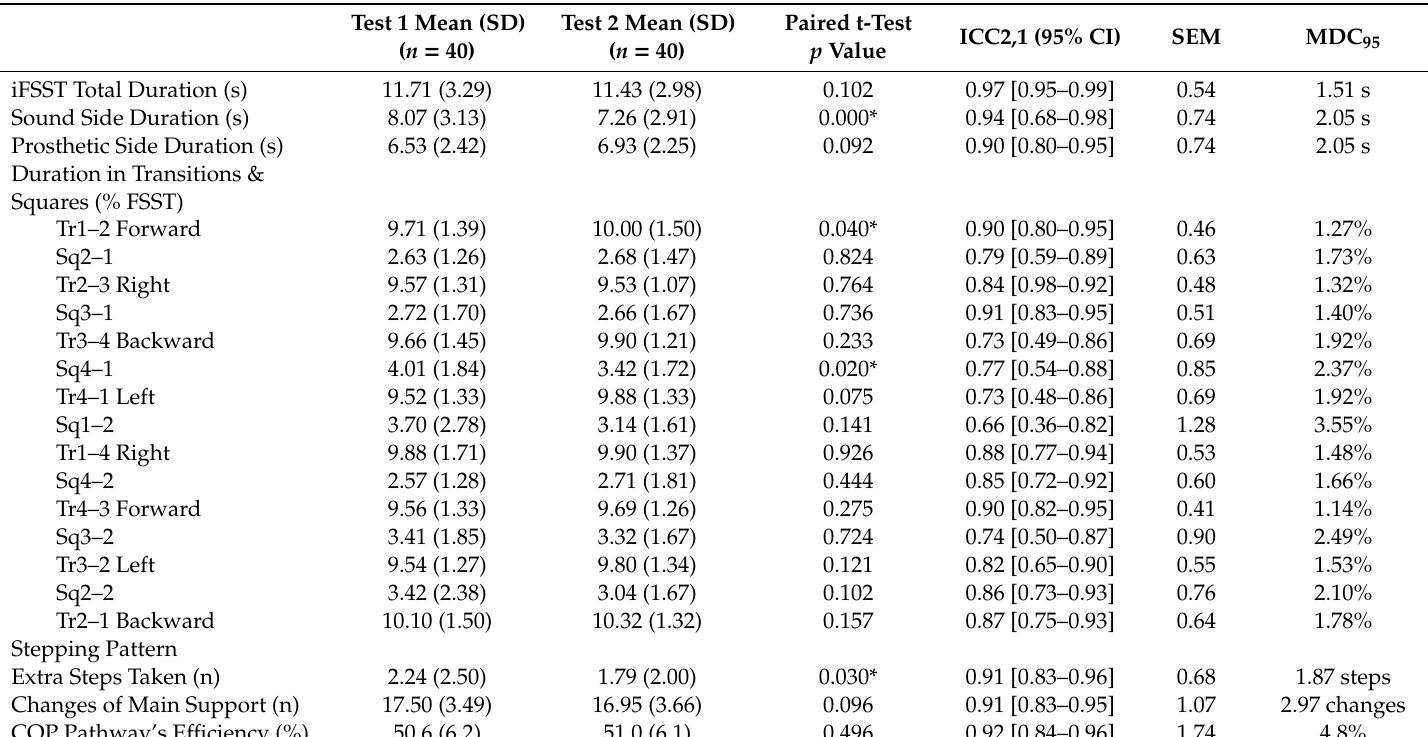
Table 2. Test-retest reliability and minimal detectable change values of iFSST variables (standard left and right